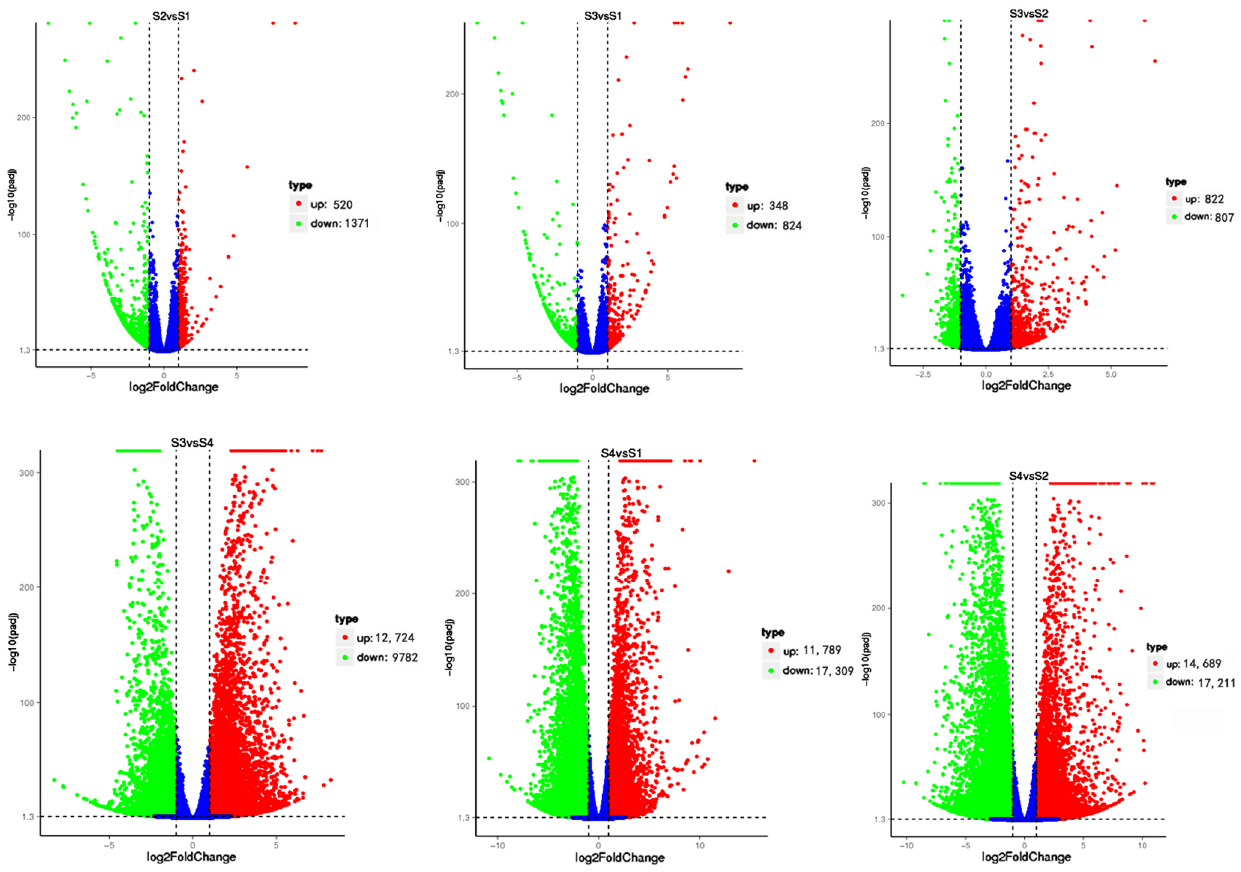
Figure 3. B. pervariabilis × D. grandis differentially expressed genes of 6 comparison groups in four periods S1–S4. Note: Red dots represent upregulated genes; green dots represent down regulated genes, and blue dots represent nondifferentially expressed genes.